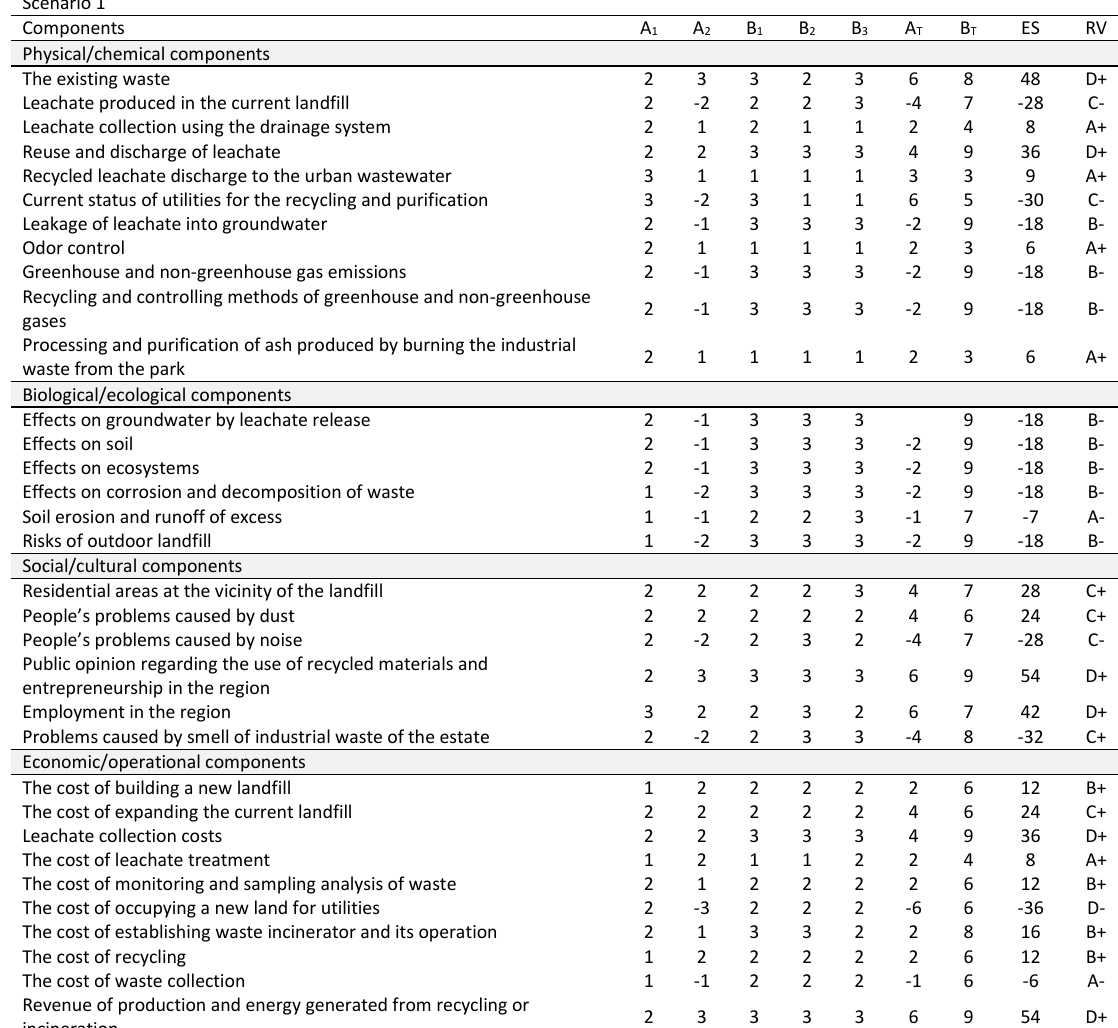
Table 9: Assessing scenario 1 through RIAM method